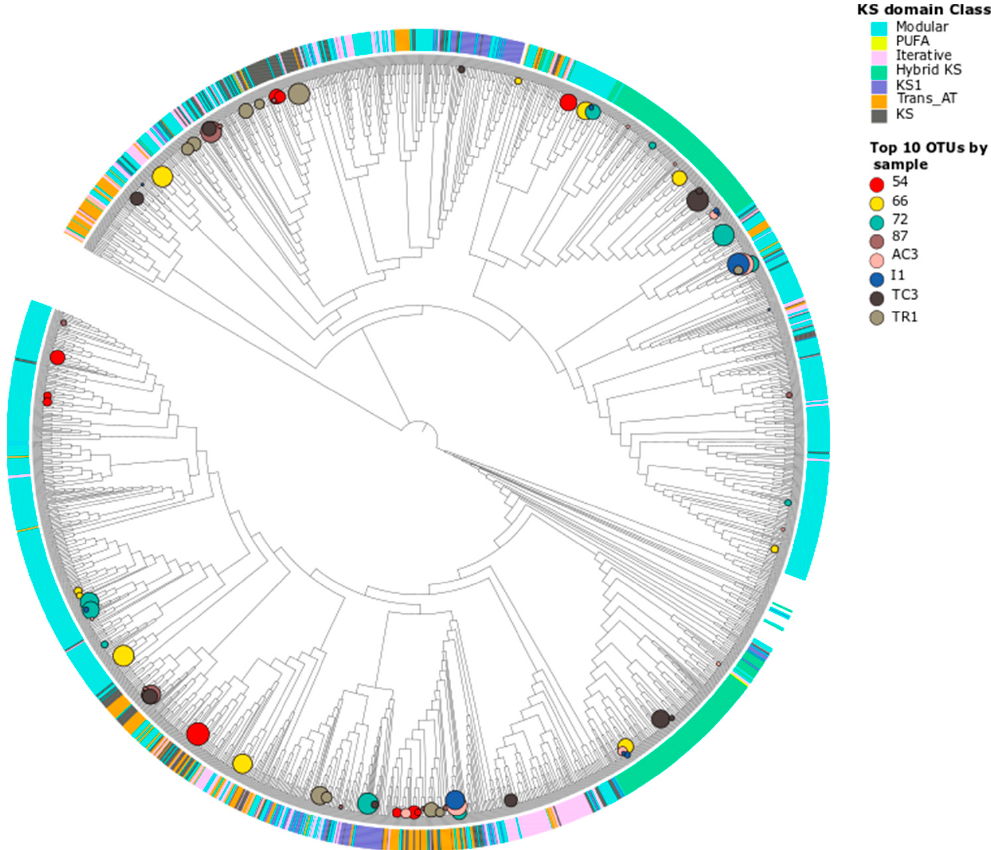
Figure 5. Maximum likelihood phylogenetic tree of KS domain OTU nucleotide sequences. The evolutionary history was inferred by using the maximum likelihood method based on the Tamura–Nei model and involved 1942 nucleotide sequences. KS classes assigned against NaPDOs database were included (color stripes) using iTOL as well as the relative abundances of the 10 most abundant OTUs by sample (represented in